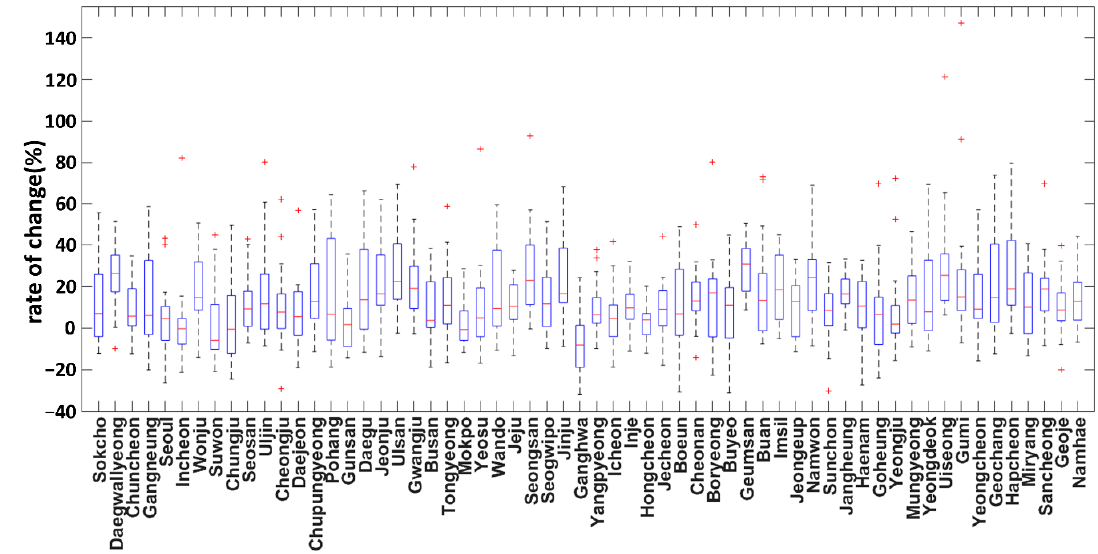
Figure 9. Boxplot of rates of change for 16 future design rainfall intensity ensembles with return period 30 years and duration 3 h at all 60 sites in Korea.